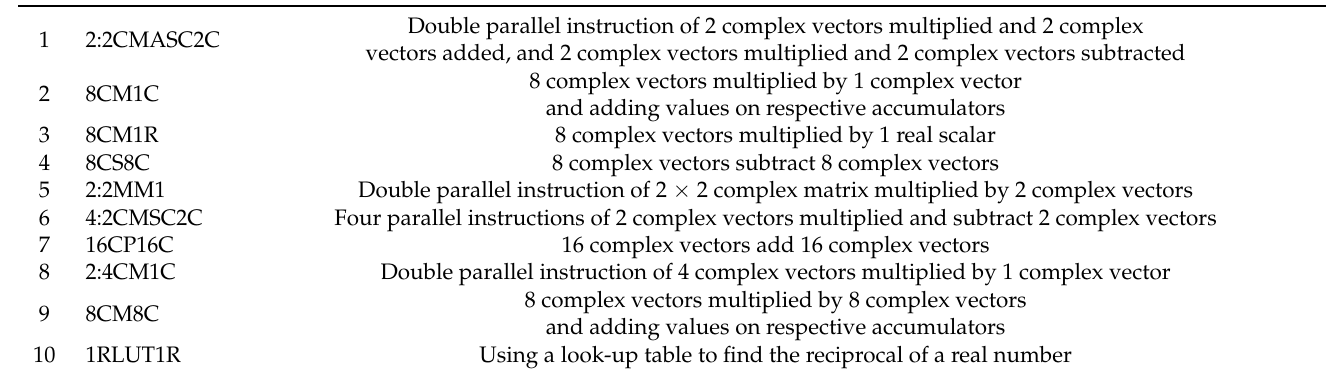
Table 2. Relatively general parallel instruction design for SIMD